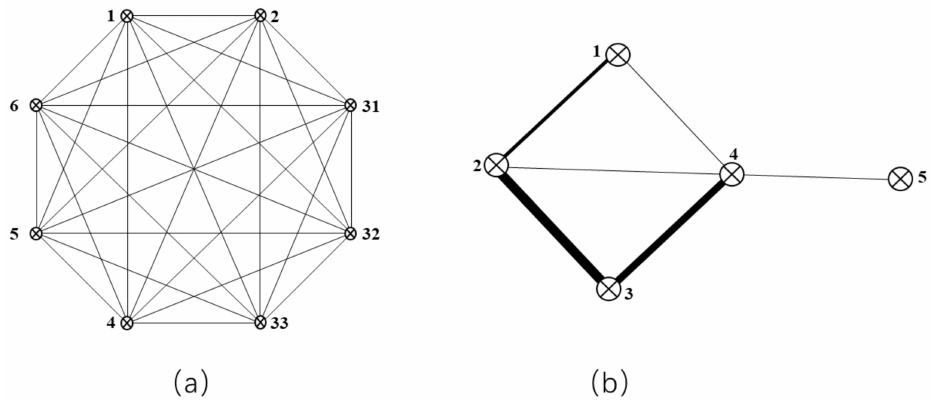
Figure 4. ( a ) A schematic diagram complex network of land use and ( b ) its one